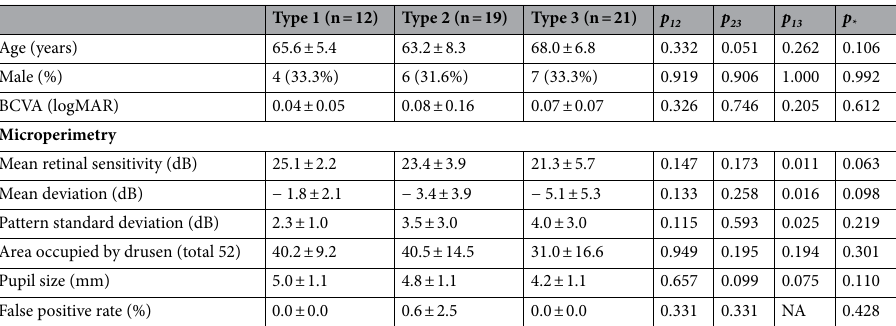
Table 2. Comparative analyses of clinical features according to the types of cuticular drusen. Data are total no. (%) or mean ± standard deviation, unless otherwise indicated. BCVA Best corrected visual acuity, logMAR logarithm of the minimum angle of resolution, dB Decibel. p 12 : p value of comparison between type 1 and type 2. p 23 : p value of comparison between type 2 and type 3. p 13 : p value of comparison between type 1 and type 3. p* : p value of comparison between type 1, type 2, and type